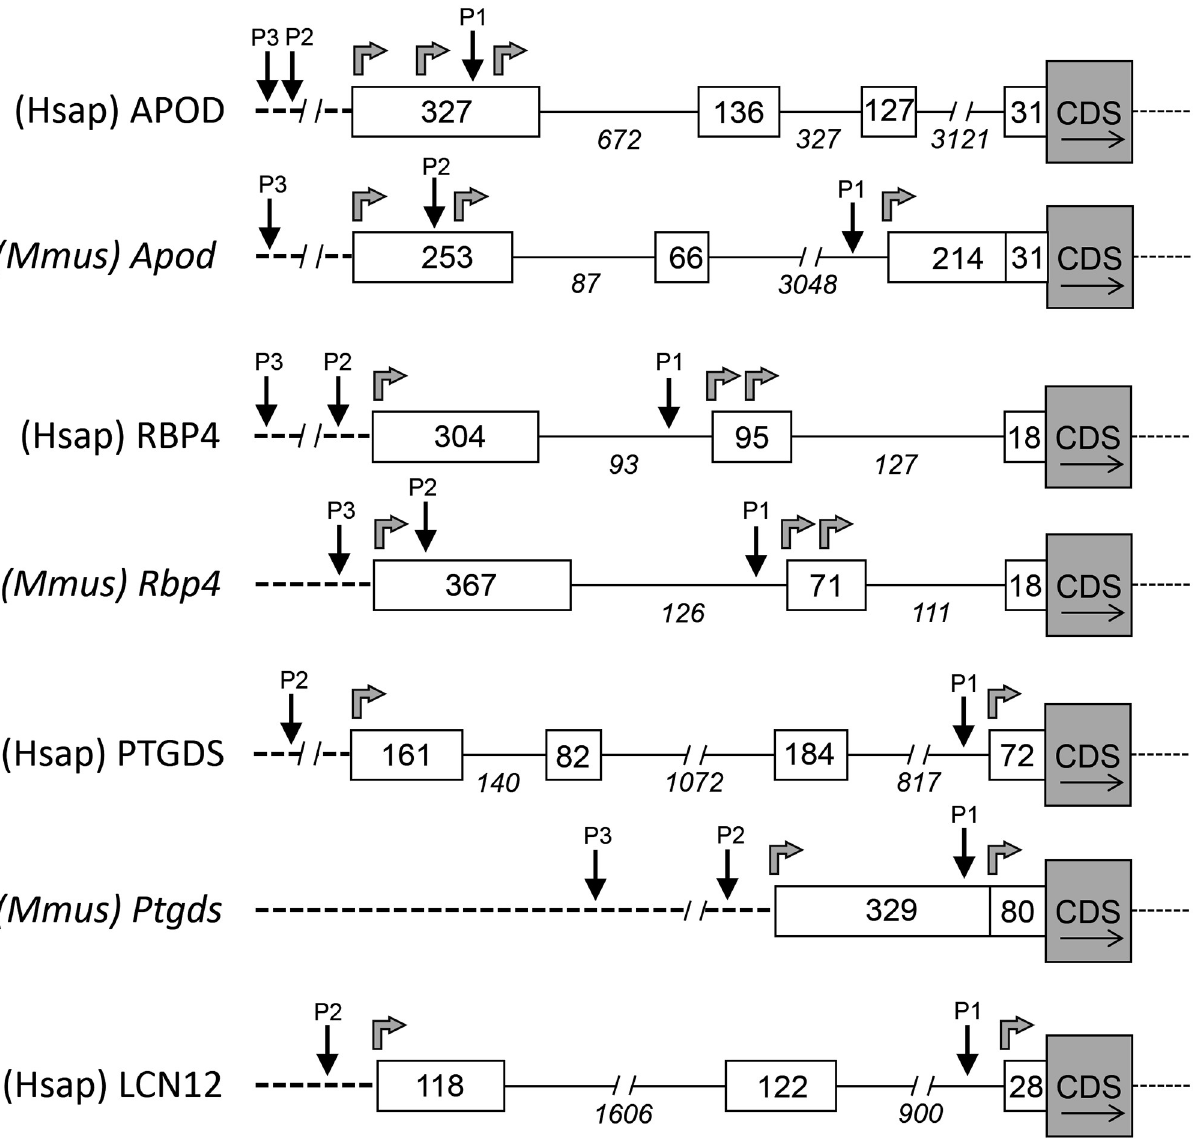
Fig 3. Architecture of genomic region of human and mouse Lipocalins with multiexonic 5’UTRs. Exon-intron structure for human (Hsap) and murine (Mmus) Lipocalin genes upstream of their CDS. Black arrows point to predicted alternative promoters (P). Gray arrows indicate alternative transcription initiation